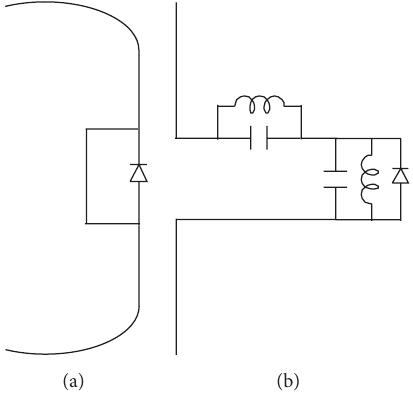
Figure 2: Schematic illustration of the two principal matching tech- niquesapplicabletoharmonictransponders:(a)directmatchingand more complex antenna geometry and (b) external matching circuit and simpler antenna geometry. The figures are only indicative and not to